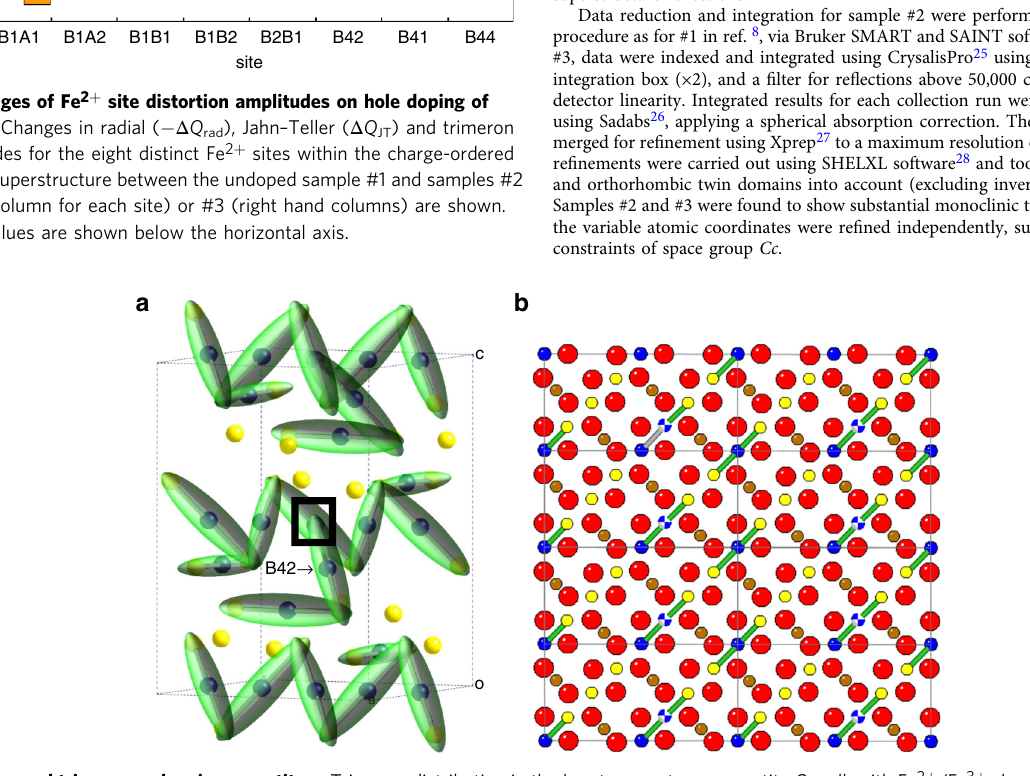
Fig. 4 Charge and trimeron orders in magnetite. a Trimeron distribution in the low-temperature magnetite Cc cell, with Fe 2 + /Fe 3 + shown as blue/yellow spheres and trimeron ellipsoids in green. The selectively oxidised B42 site is labelled, and the unusual termination of its trimeron by another Fe 2 + is marked by a square. b (100) surface of cubic magnetite showing trimerons in the surface layer. The B42 sites (blue and white ‘ beachballs ’ ) are expected to be oxidised in preference to other trimerons. Charge-ordered Fe 2 + /Fe 3 + are shown as blue/yellow spheres, tetrahedral Fe/O sites are